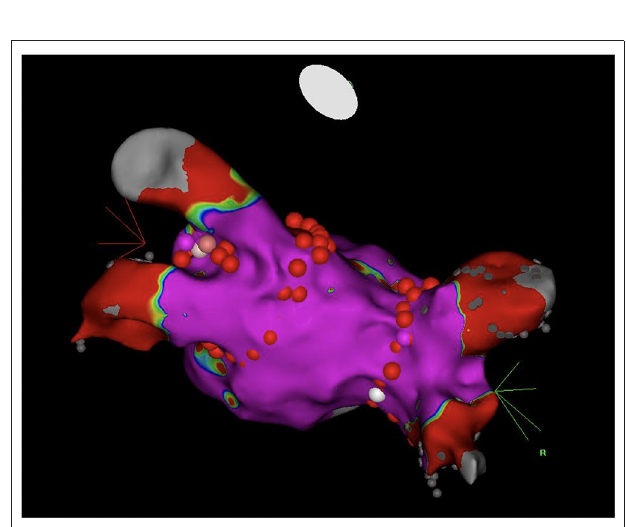
FIGURE 3 | Cranial posterior aspect of the left atrium depicting the lines of antral ablation for pulmonary vein isolation. Normal myocardial voltage ( > 0.5mV) is marked purple during electroanatomical